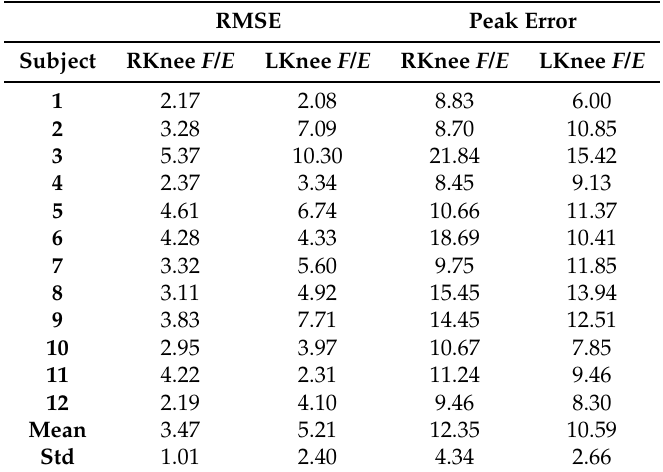
Table 7. Error (degrees) of IMU joint angles vs. mocap joint angles for the motion profile dataset. F/E refers to flexion/extension of the joint. RMSE Peak Error Subject RKnee F/E LKnee F/E RKnee F/E LKnee